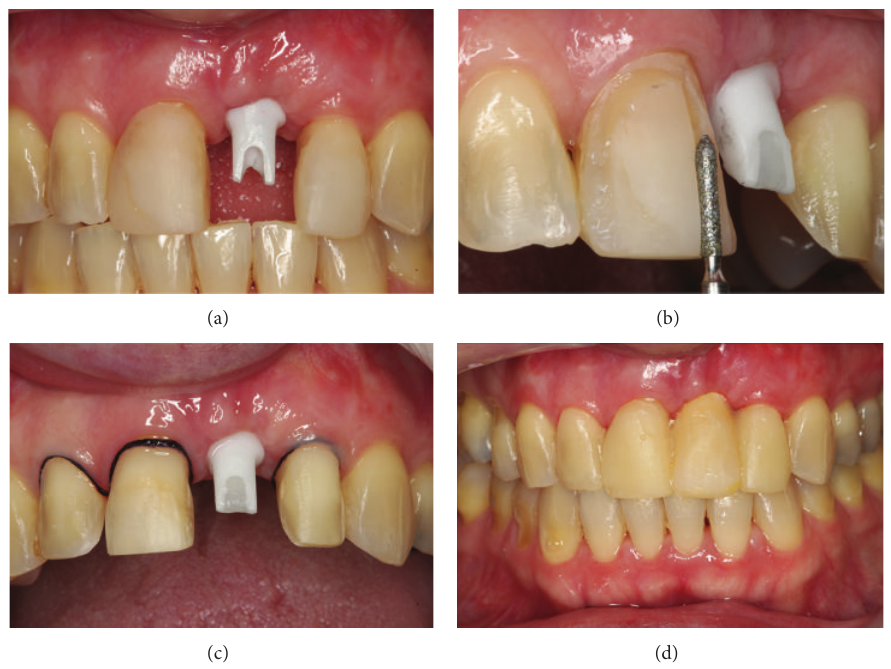
Figure 11: Zirconia custom abutment installed and teeth preparation to receive the final prosthesis.